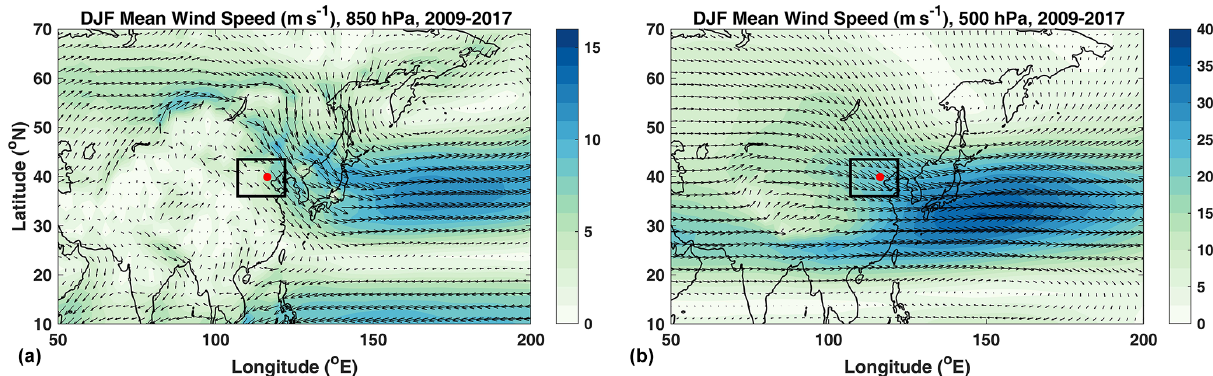
Figure 1. Average wind speeds at the (a) 850hPa and (b) 500hPa pressure levels. The red dot represents the location of Beijing and the black rectangle shows the location of the NCP. This figures was also generated for a longer average period, i.e. 1979–2019 (not shown), and the results were